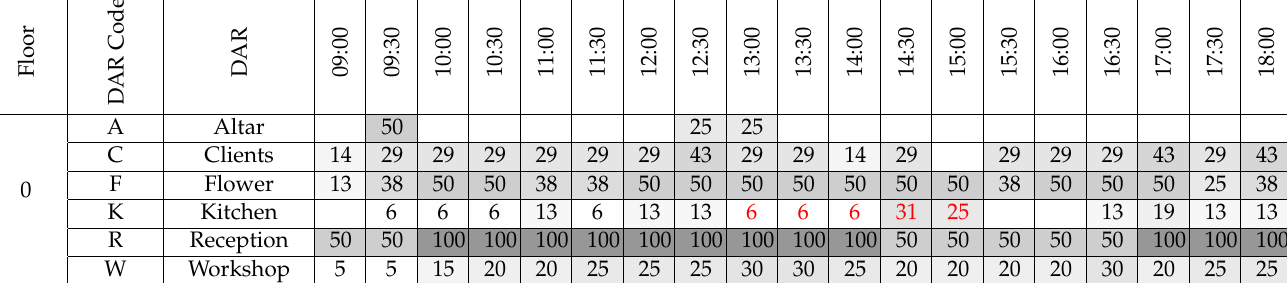
Table 8. Occupancy table highlighting kitchen occupancy during regular lunchtime (between 13:30 and 15:30). Numbers indicate the number of employees occupying the kitchen divided by the capacity of the space, expressed as a percentage. The number of employees present at each space per hour. Dark colors highlight the areas with more users present at a time.